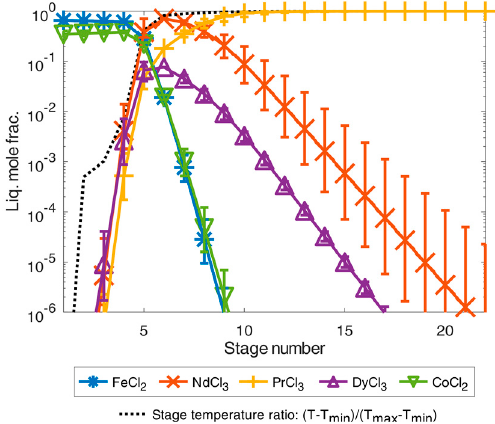
Figure 8. Illustration of separation of high-purity REEs by distillation simulated in an exemplary total-reflux column under simplified idealized phase equilibrium conditions according to Equation (1) for the feed composition case from [24]. The error bars show the results for a deviation of the calculated temperature of ±5%.